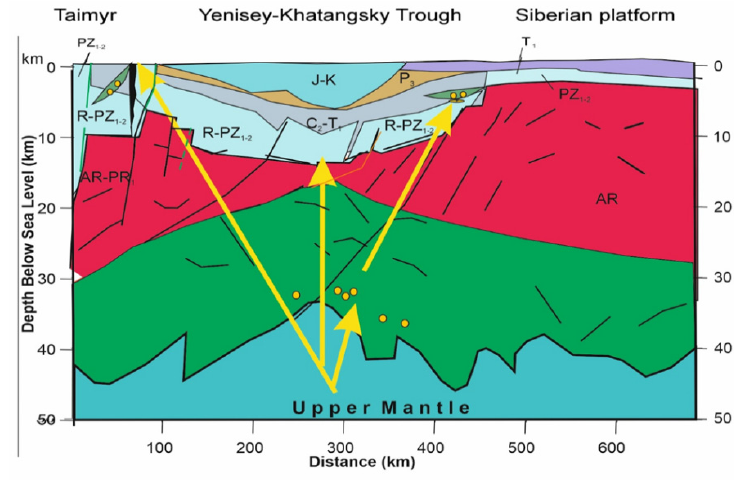
Figure 25. Schema of deposits’ formation in the NW Siberian Platform.